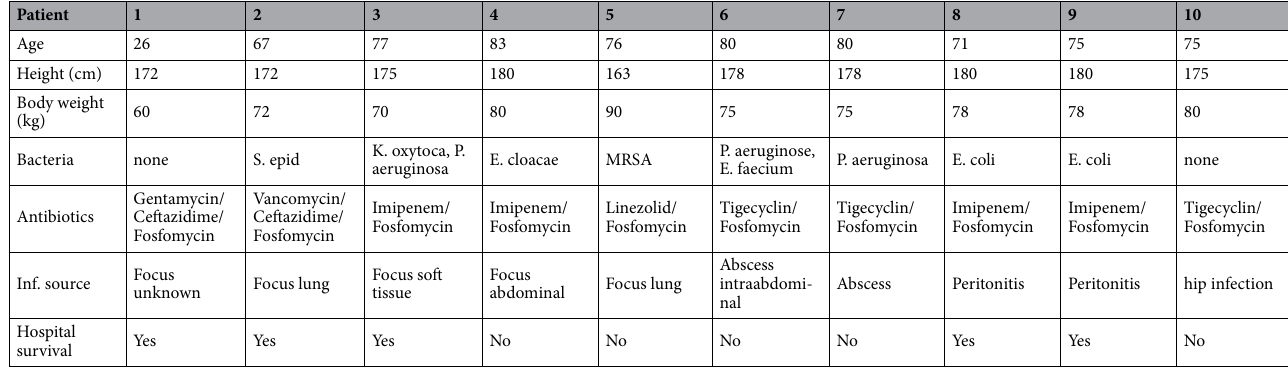
(Table 1). One patient suffered from sepsis of unknown focus without detection of bacteria. (Table 1).